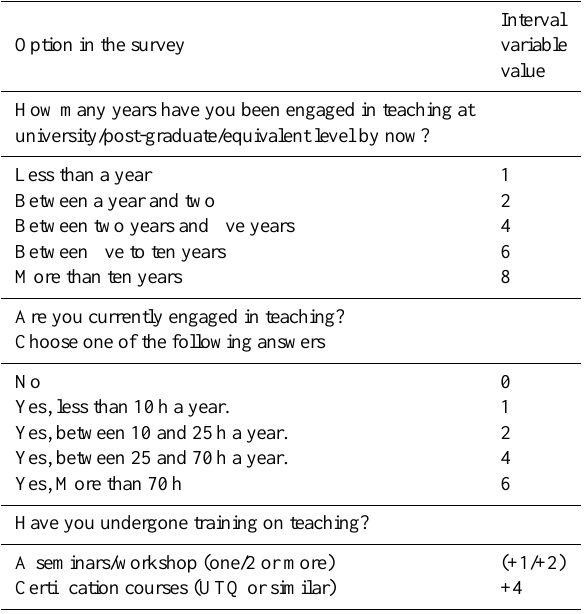
Table A1. The scales used to convert some choices to interval variables for statistical analysis.